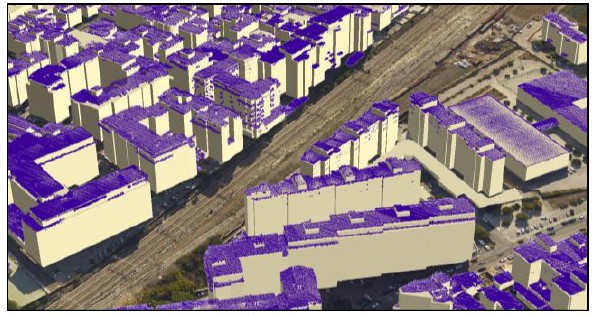
Figure 8 - Roof and balcony point clouds.